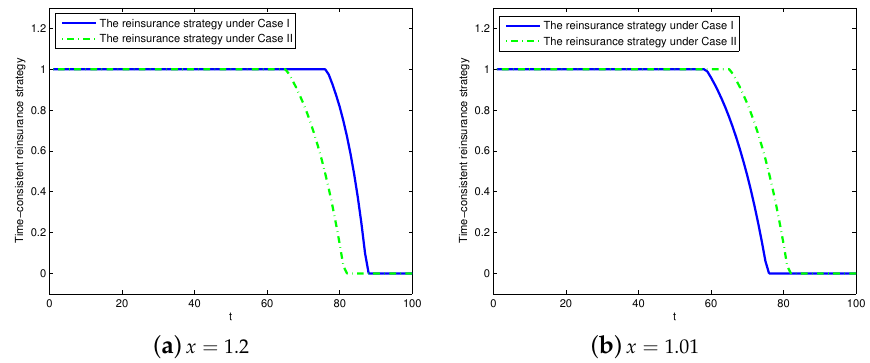
Figure 5. Nash equilibrium reinsurance strategy under the expected value premium principle ( α =